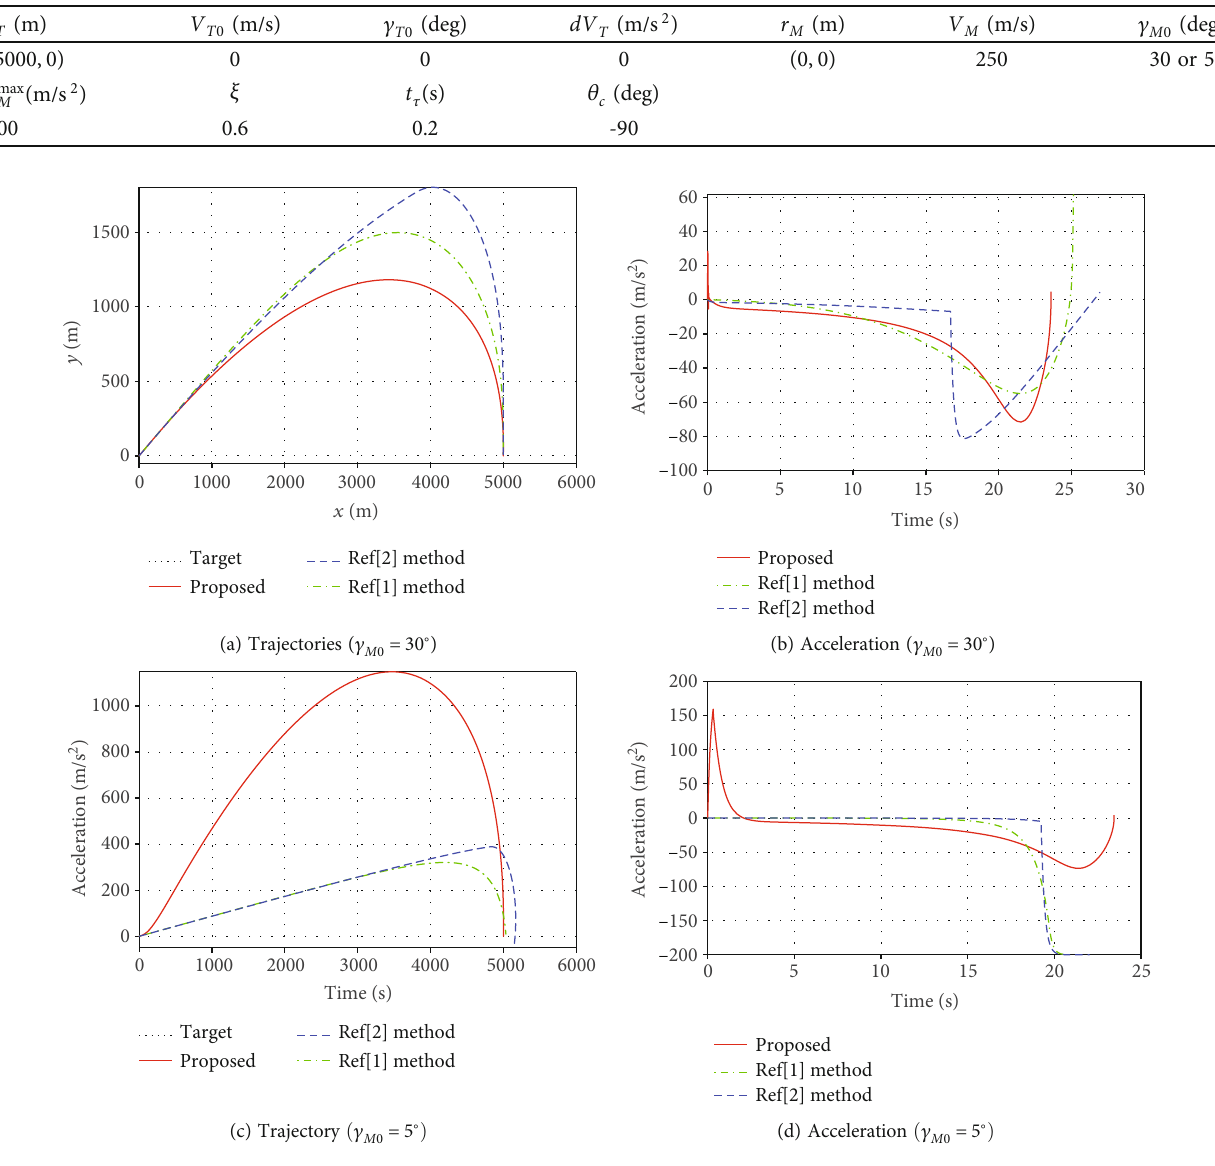
Figure 8: Case II: stationary